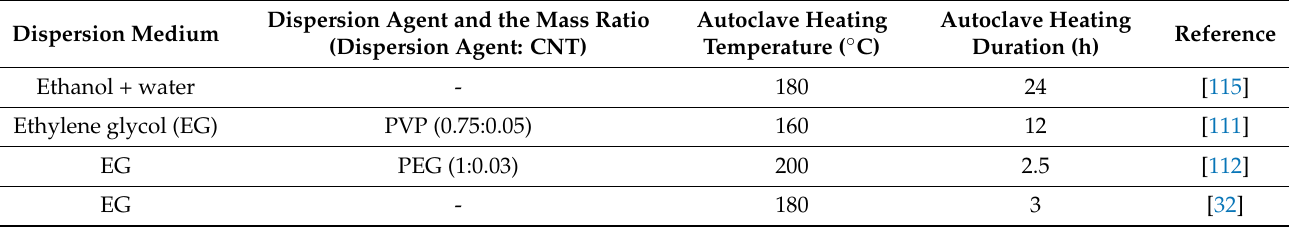
Table 5. Optimized dispersion agent and autoclave heating parameters of solvothermal